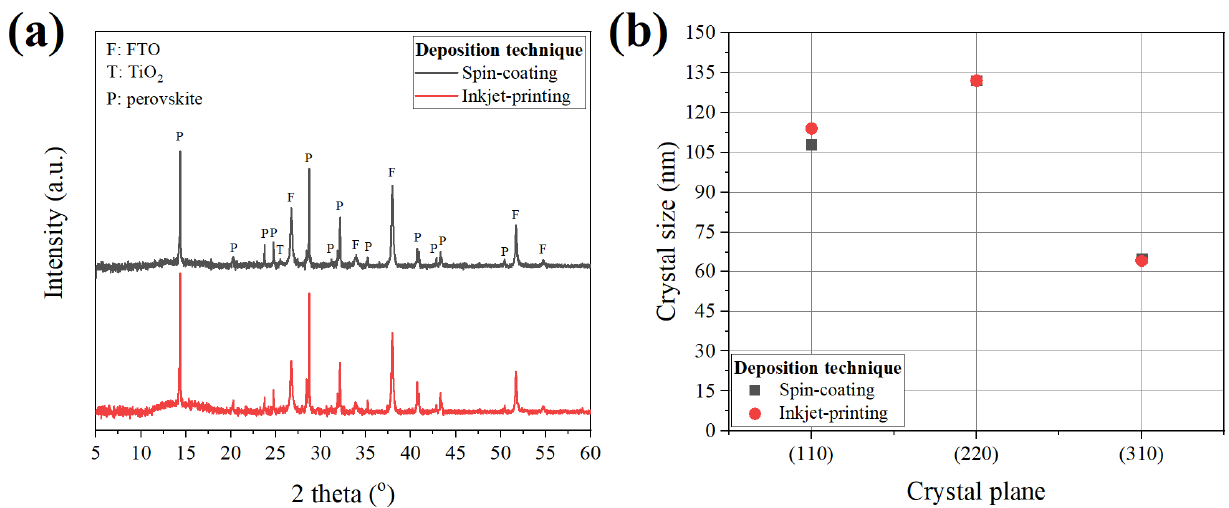
Figure 1. ( a ) XRD patterns and ( b ) mean crystal sizes in the primary crystal planes of the perovskite films fabricated using the different deposition techniques of the perovskite precursor solution on the m-TiO 2 layer.